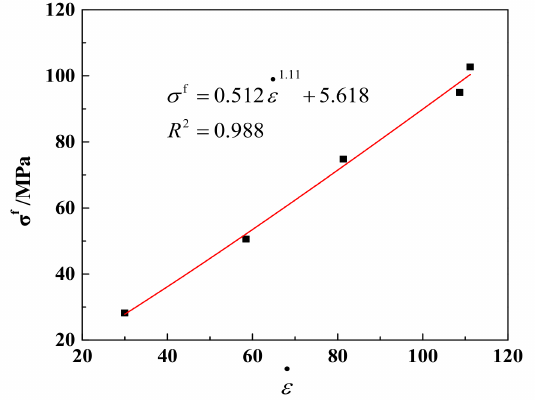
Figure 7. Relationship between peak stress and average strain